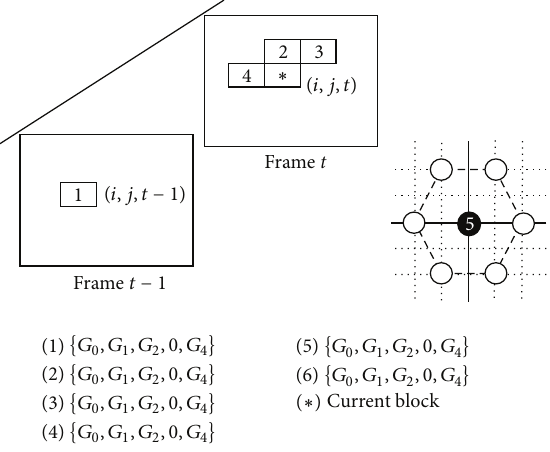
Figure 19: The initial six chromosomes